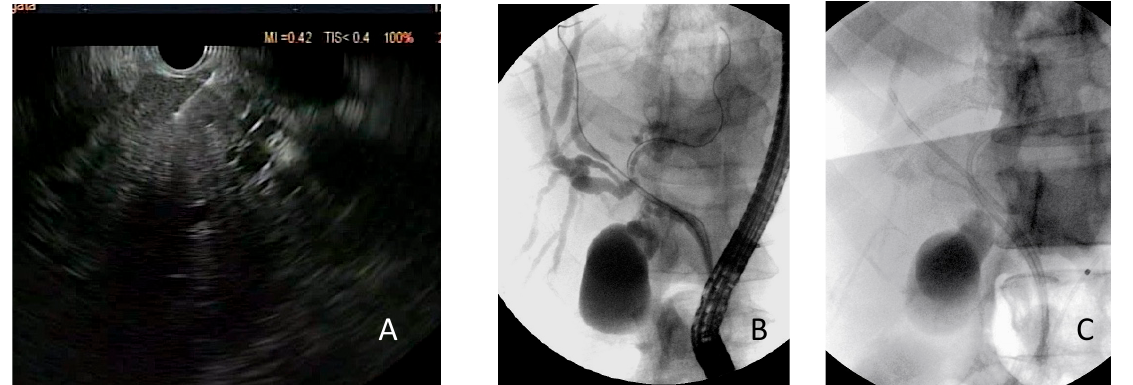
Figure 1. Case of proximal biliary stenosis with liver nodule finally diagnosed as cholangiocarci- noma. ( A ) EUS-FNB of the liver nodule. ( B , C ) Biliary drainage performed after the placement of two guidewires ( B ) with plastic stenting ( C ) in the same session as the EUS procedure.